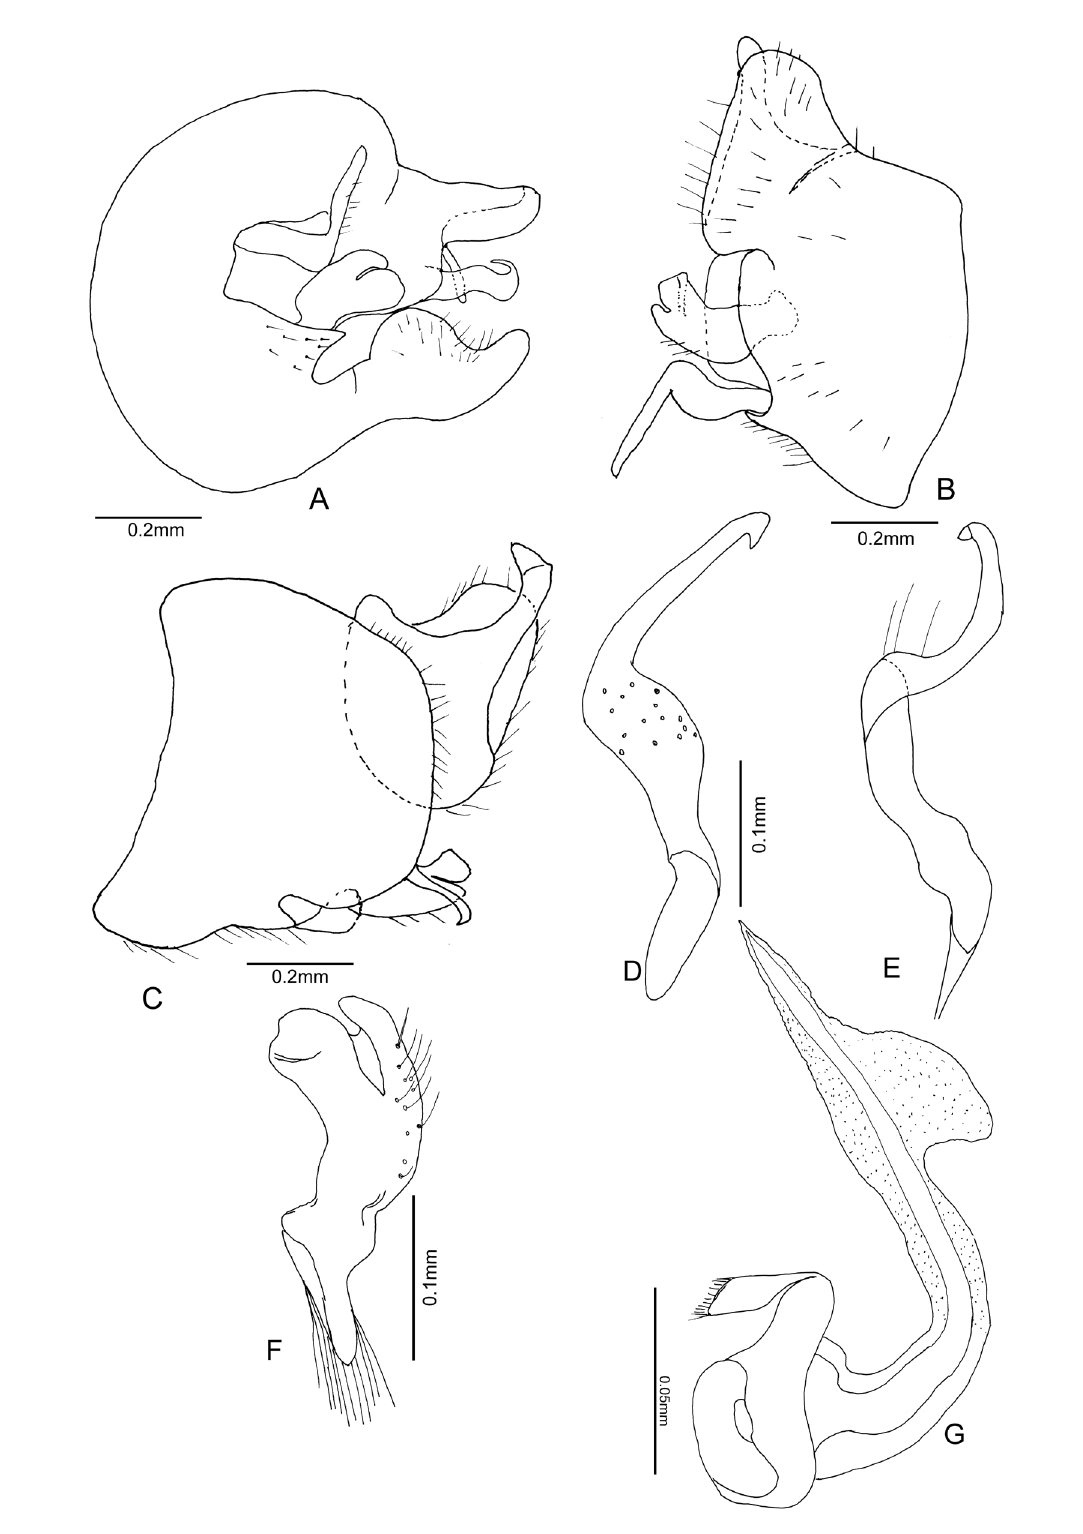
Fig. 14. Male genitalia of Harpedona marginata Distant, 1904, NHM. A–C . Genital capsule in ventral and lateral views. D–E . Right paramere in dorsal and lateral views. F . Right paramere in dorsal view. G . Aedeagus in lateral